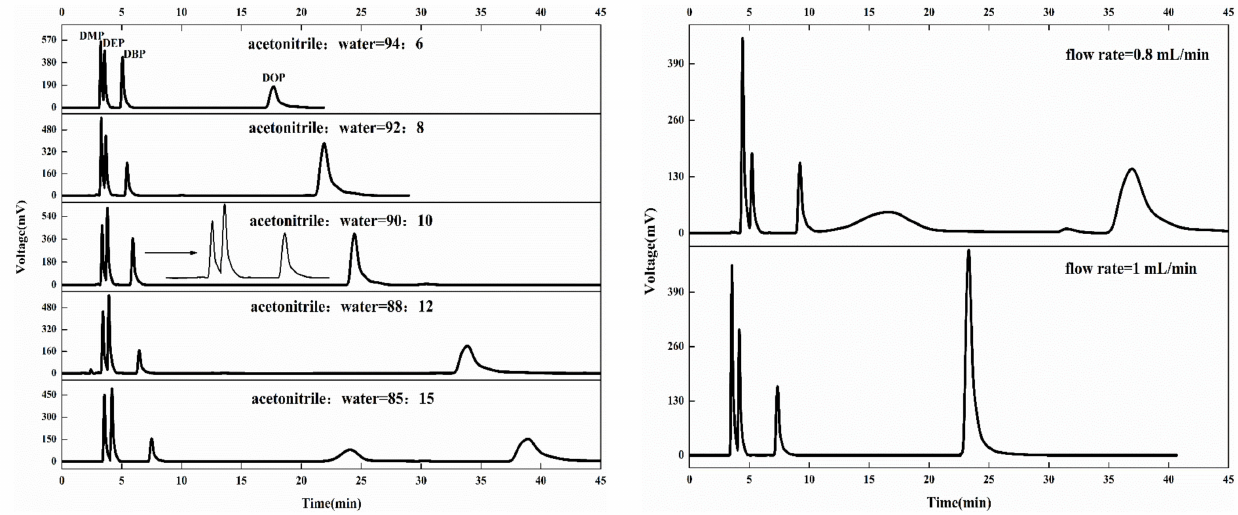
Figure 3. Effect of different mobile phase ratio and flow rate on PAEs separation